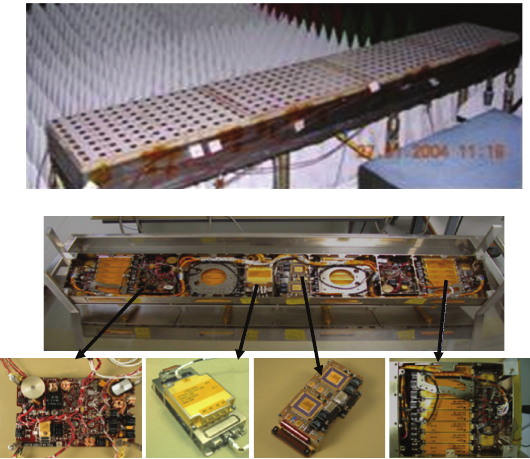
Figure 5: Tile external & internal view: TPSU, TTDL, digital controller and EFE with 8 TR modules are shown (from left to right).